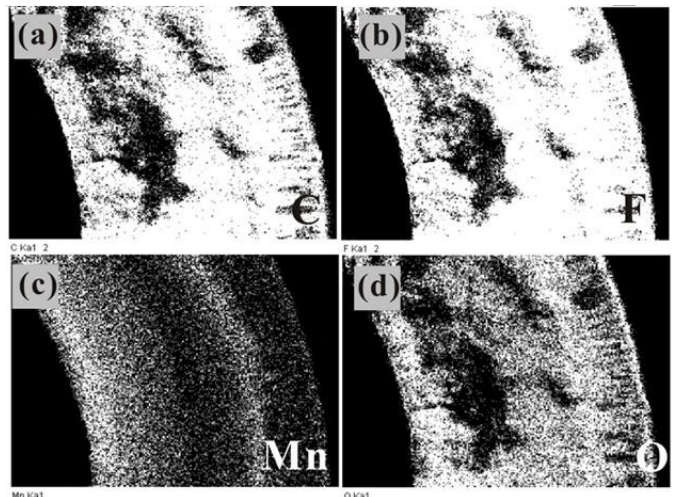
Figure 3. Mapping image of the MnO 2 /PTFE HFM of: ( a ) C element; ( b ) F element; ( c ) Mn element; ( d ) O element.